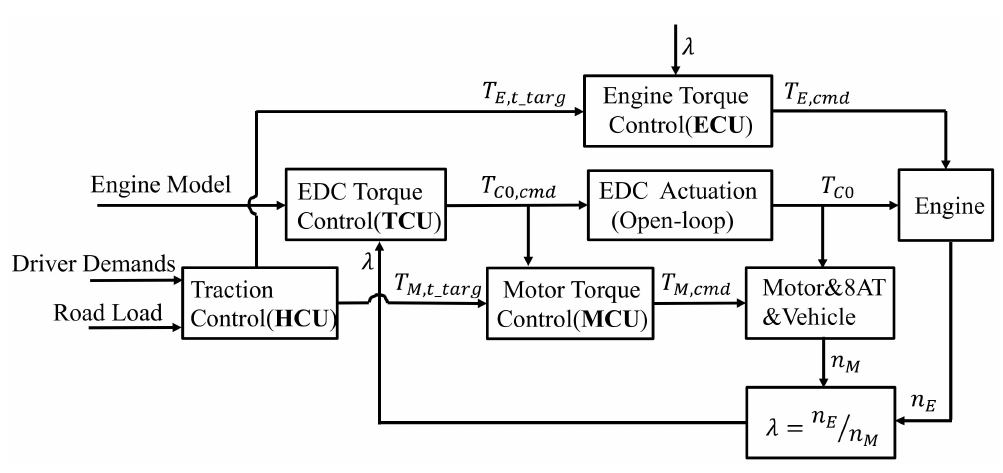
Figure 11. Coordinated control architecture of